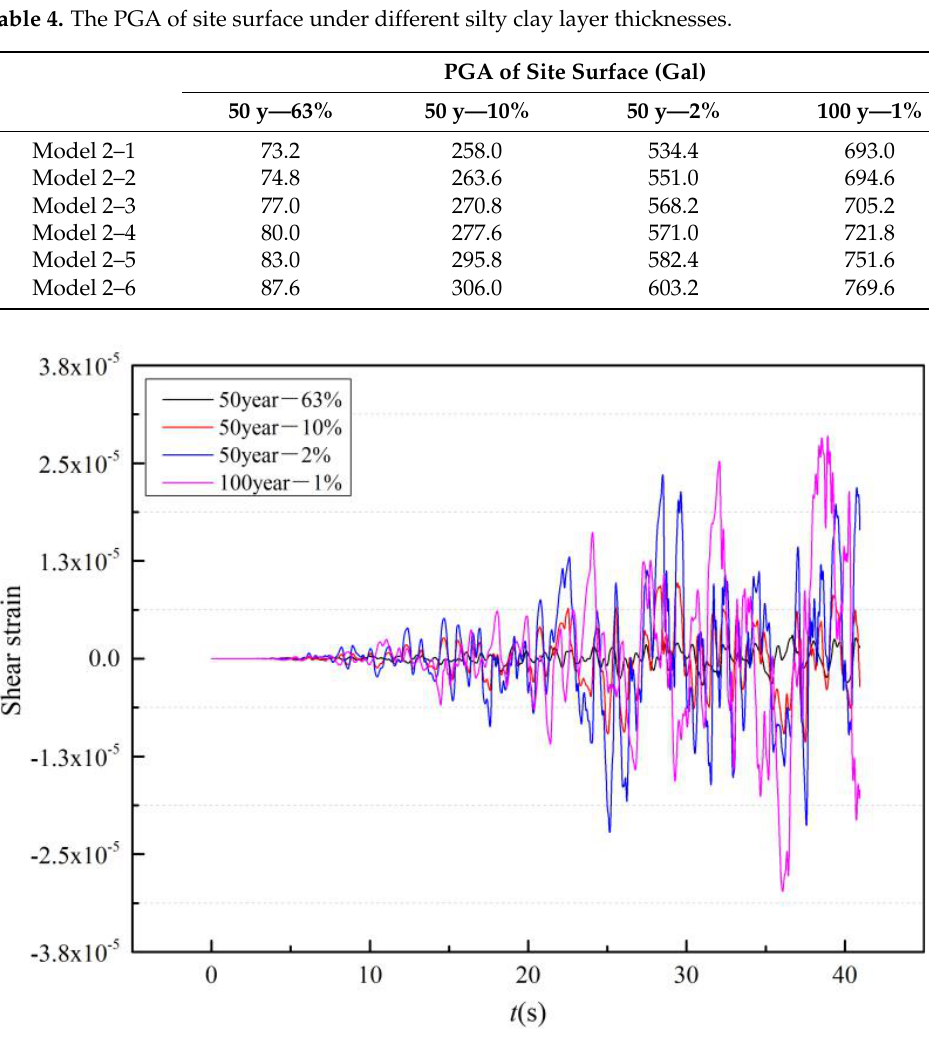
Figure 8. Amplification ratios of ground motion for the different thicknesses of silty clay layer under four seismic inputs. As shown in Figure 9, the pebble soil site in the Zhongwei Basin has an obvious am- plification effect on the short-period seismic waves, and the periodic peak points of the response spectrum are all within 0.1 – 0.2 s. Under the action of frequent earthquakes, basic earthquakes, and rare earthquakes, the site significantly amplifies the short-period com- ponent of the earthquake but has little effect on the long-period component. Under the action of the extremely rare earthquake, the response spectrum curve shows an obvious “double peak phenomenon”, and the second peak point appears in the period of 0.5– 0.7 s. The amplitude of the response spectrum increases with the thickness of the overlying silty clay layer under frequent earthquakes, basic earthquakes, and rare earthquakes. Un- der the extremely rare earthquake, the response spectrum curve shows strong dispersion before 0.3 s. This result is surprisingly similar to the findings of another recent study on the effects of deep soil sites atop deep geological sediments on surface ground motion, in which a spectral peak at 0.5 s was also found [24].